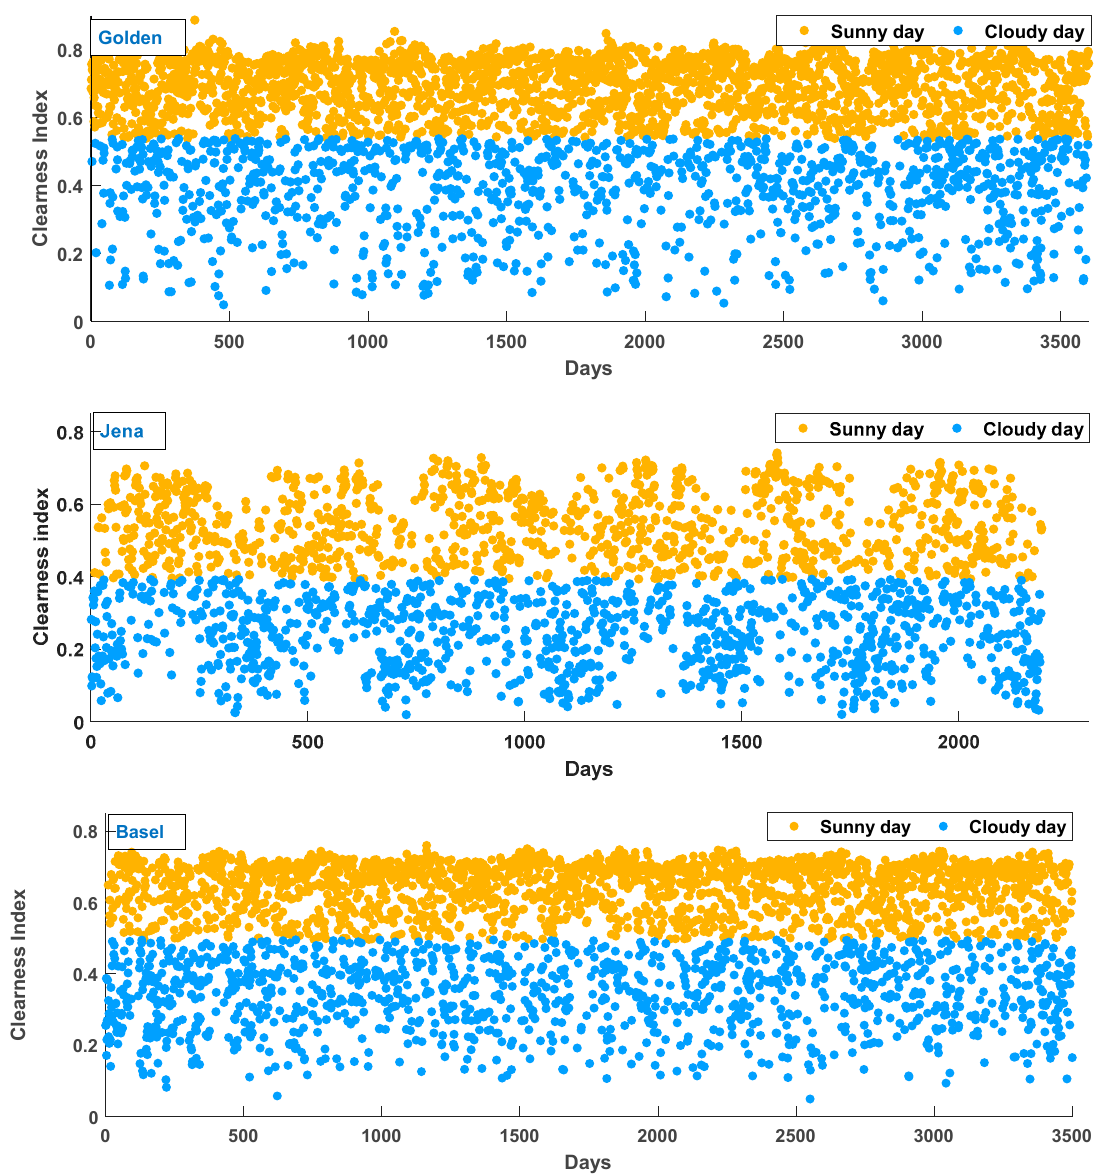
Figure 6. The classification of days via k-means clustering for the study locations. The results obtained using the various models are presented and evaluated according to their RMSE, NRMSE, MAE, and NMAE values in Table 5. In addition, the average NRMSEs of the four models for the three geographical locations are indicated by the bar charts in Figure 7. Thus, it can be seen that the proposed LSTM model gives the best performance for all three locations, followed by the FFNN and SVM models, while the persistence model gives the least accurate forecasting